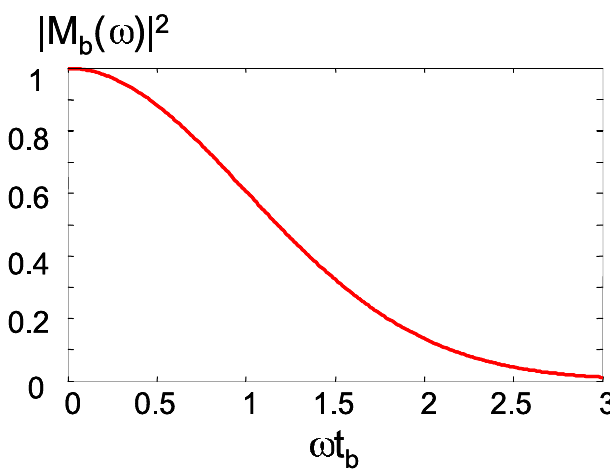
(cid:2) ! (cid:3)j 2 (cid:4) exp (cid:2)(cid:1) ! 2 t 2 b